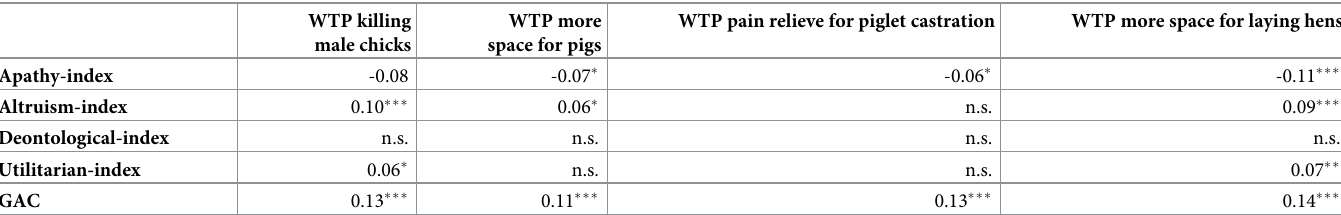
Table 3. Correlation coefficients of moral values and willingness to pay ( (cid:3) = 0.05, (cid:3)(cid:3) = 0.01, (cid:3)(cid:3)(cid:3) = 0.001, n = 1334).